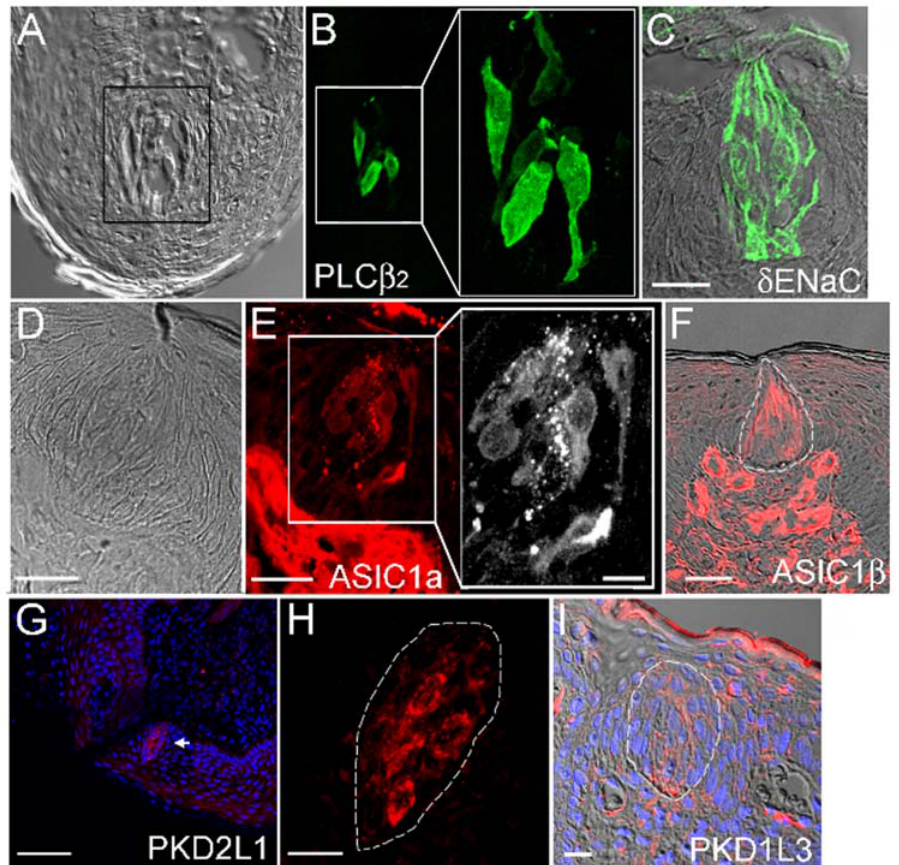
Figure 5. Immunohistochemical staining of the protein products of taste-related genes expressed in the fungiform papillae of sour- normal subjects. The gray image of Panel A is a fungiform section showing taste buds under Nomarski optics. The image in Panel B is of the same section as A, but showing the section immunostained with antibodies to PLC- b 2. Panel C displays immunostaining with antibody to d -ENaC, overlaid on a Nomarski picture of the same tissue section. The human taste bud is known to be invested with the d form of ENaC at the expense of the a form [36]. Panel E shows immunoreactivity to antibody against ASIC1a, with the Nomarski optics of the same section displayed in Panel D . The taste bud area of the section in Panel E is magnified to a larger black and white image showing the specific labeling of the characteristic spindle-shaped cells within a taste bud. Panel F shows immunoreactivity to antibody against ASIC1 b in the taste bud (outlined) and in the plexus, overlaid on a photo of the same section under Nomarski optics. The distribution of the channels PKD2Ll and PKD1L3 in the human fungiform papilla is shown in Panels G, H and I . Panels G and H display immunoreactivity toward the ion channel PKD2L1. A DAPI overlay marks each cell. The arrow in Panel G points to a taste bud. This taste bud appears in Panel H at an approximately five-fold magnification. Note the labeling of the membranes of several taste cells. Panel I shows distribution of immunoreactivity to an antibody made against PKD1L3. It shows the upper portion of a human fungiform papilla using Nomarski optics overlaid with the immunohistochemical label from an antibody against PKD1L3 and DAPI stain. A taste bud is outlined. The label for PKD1L3 appears between cells and is likely not labeling the membrane of the taste bud cells because the label does not appear in the cells, as it would were the antibody recognizing an antigen on the taste cell. The bars on each Panel show the magnification: A & B : the box width is 40 m m, blow-up in Panel B is a 2-fold magnification of the left smaller box; C : 20 m m; D & E : 25 m m with Insert E : 10 m m; F : 25 m m; G : 80 m m; H : 15 m m; I : 15 m